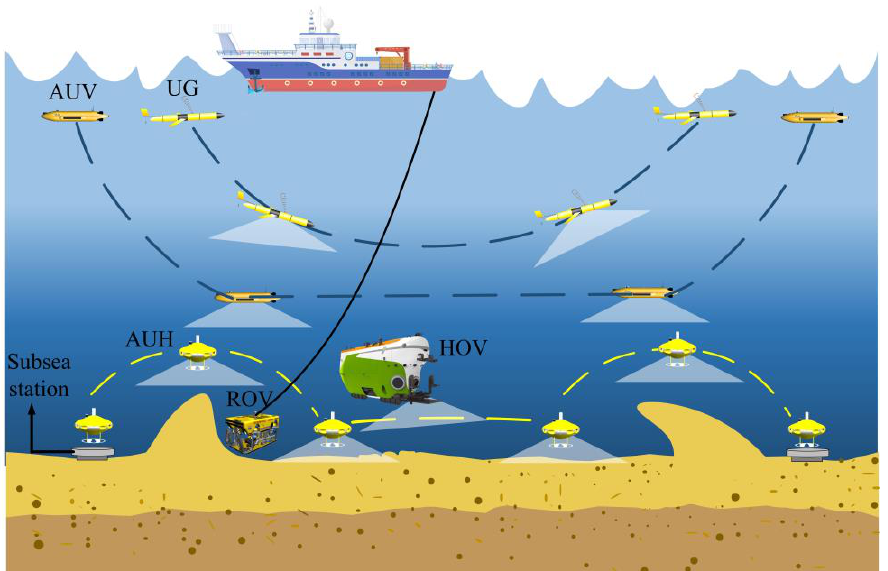
Figure 1. Submarine mobile observation network.